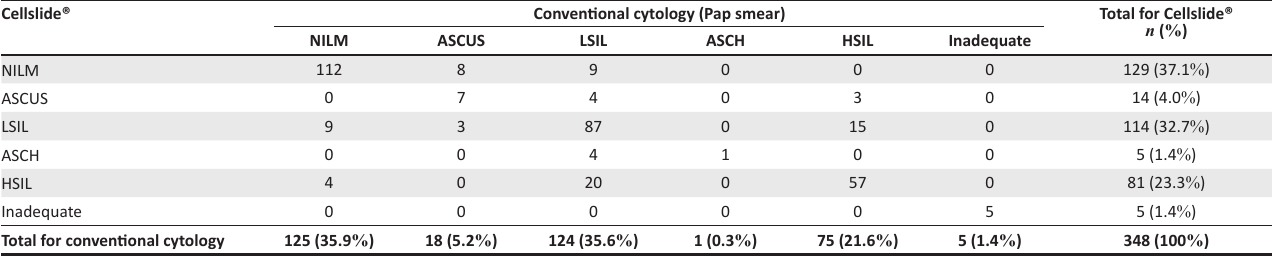
TABLE 1: Results from conventional cytology and Cellslide® automated liquid-based cytology amongst HIV-positive women ( n = 348) in Johannesburg, South Africa (November 2009 to August 2011). †